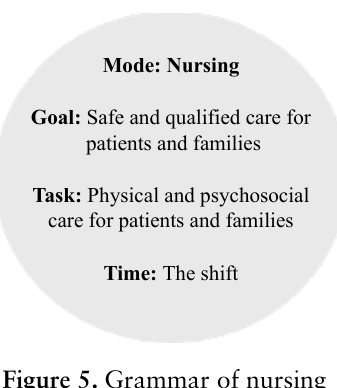
Figure 5. Grammar of